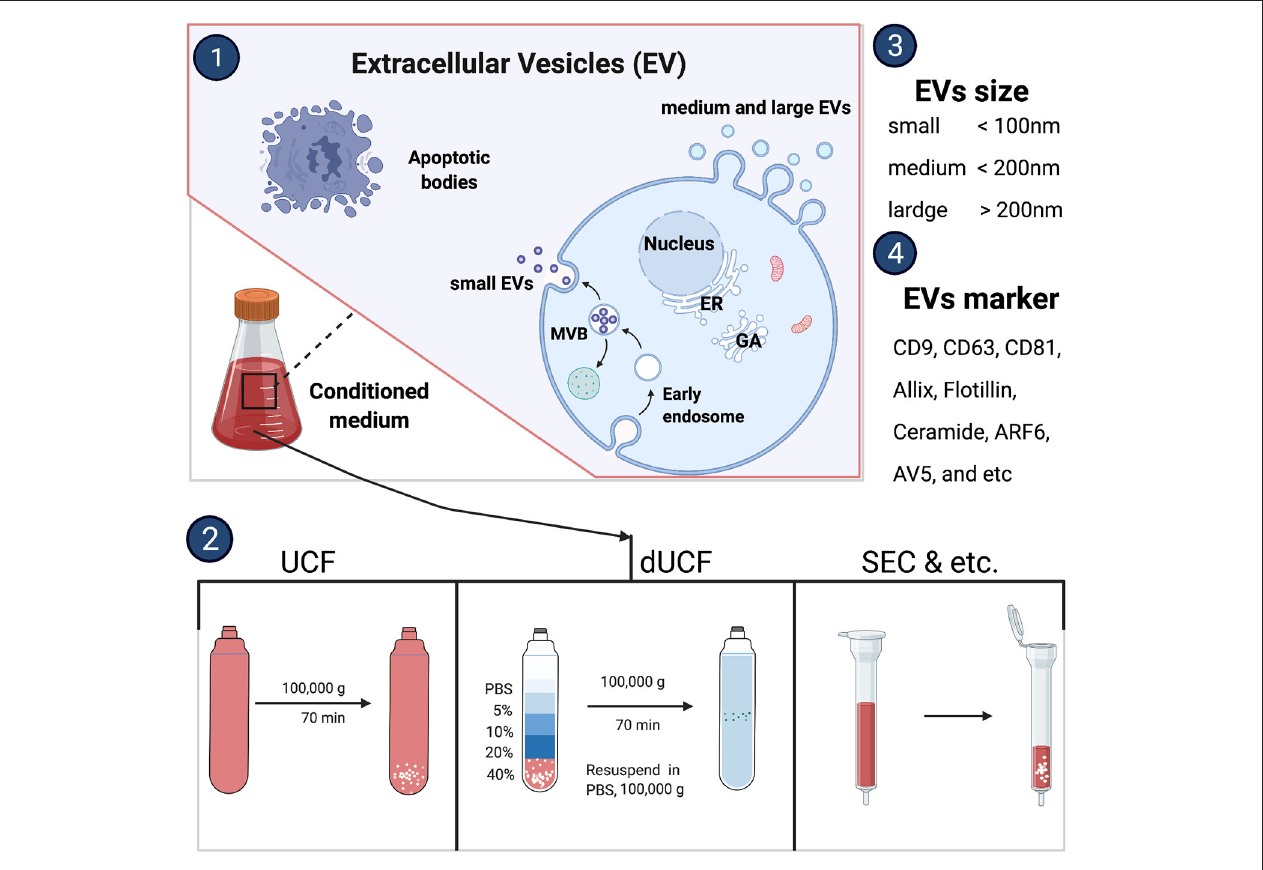
FIGURE 2 | Extracellular vesicles biogenesis and isolation methods. UCF, ultracentrifuge; dUCF, density gradient centrifugation, size-exclusion